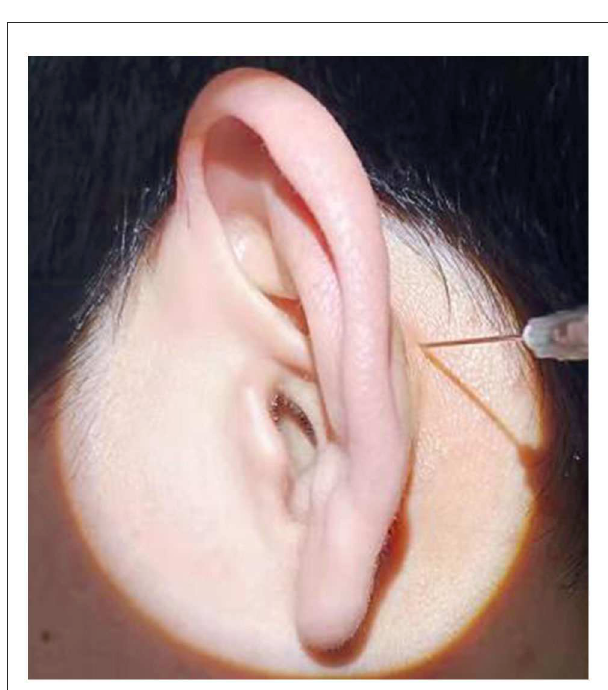
FIGURE3 Postauricular subperiosteal methylprednisolone injection for SSNHL